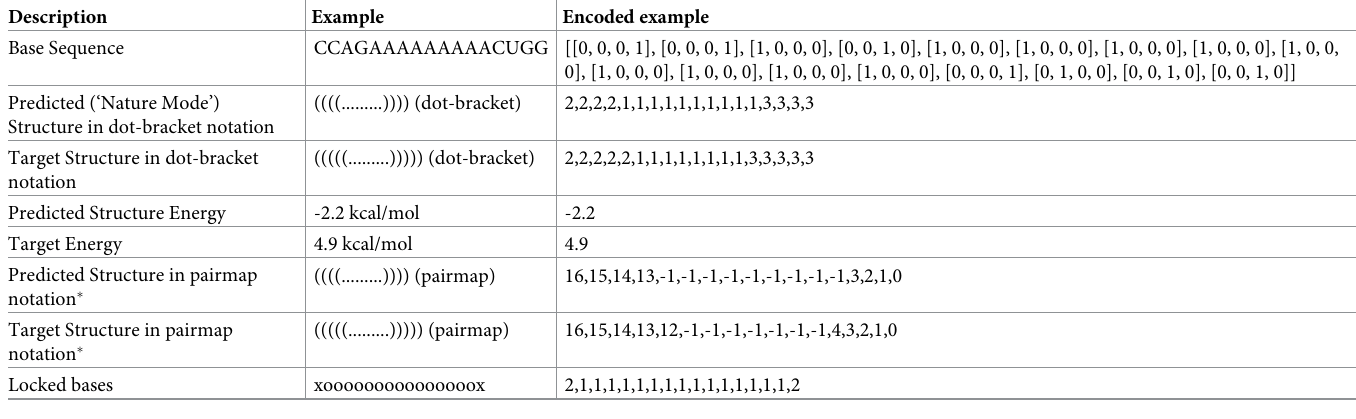
Table 1. Input features used for training and testing EternaBrain convolutional neural